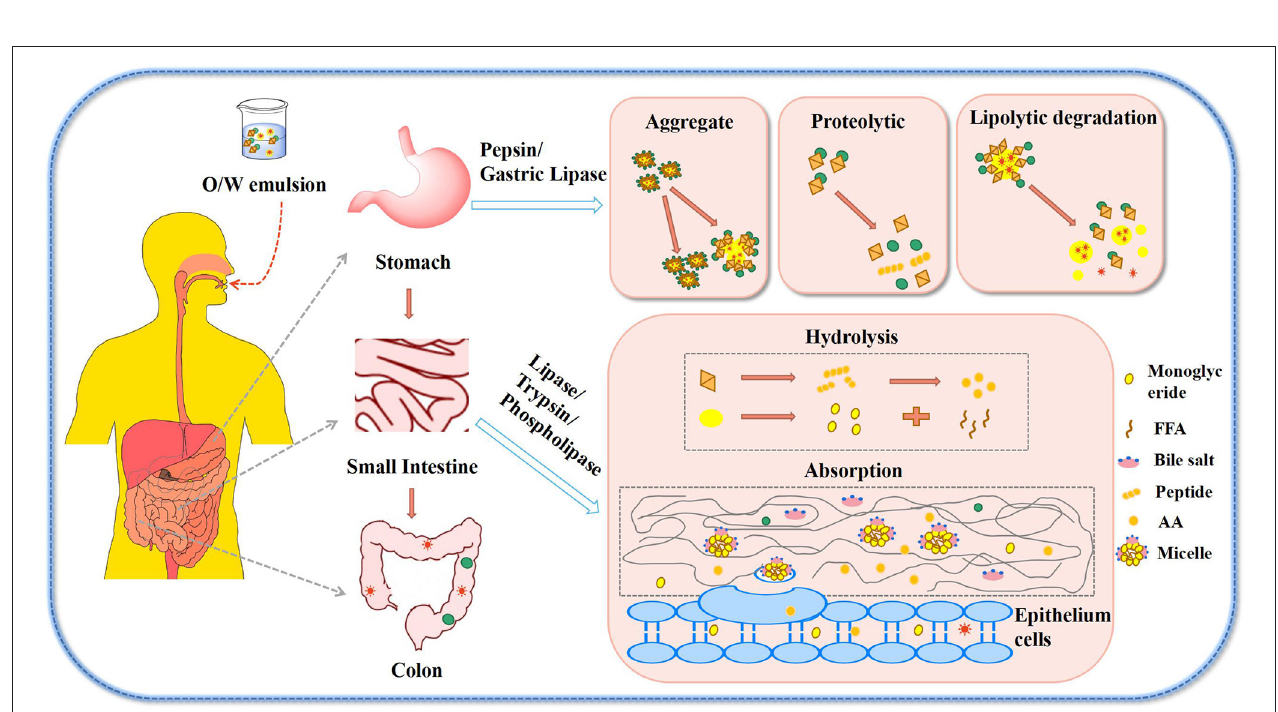
FIGURE 4 | Digestive behavior of protein-polyphenol stabilized O/W emulsion.